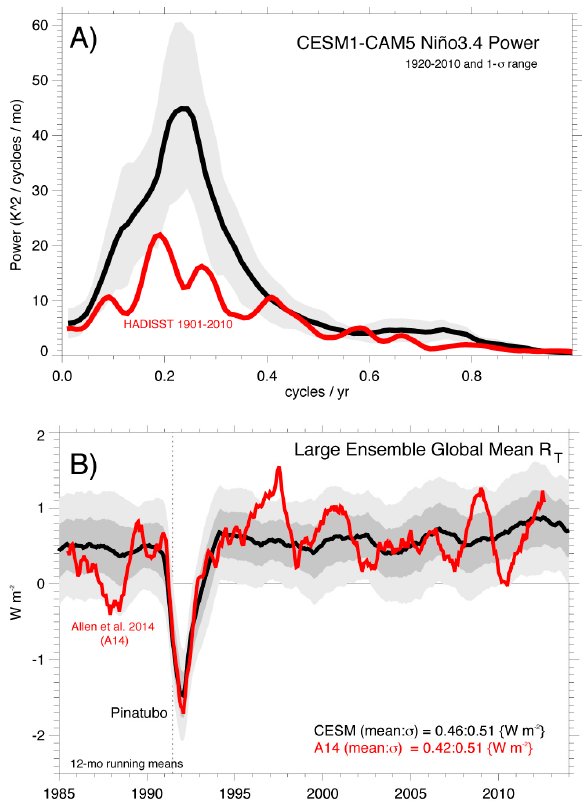
Figure 2. Evaluation of: ( A ) the power spectrum of Niño3.4 sea surface temperature in the LE (black) and an estimate from HADISST (red); and ( B ) the time series of net top ‐ of ‐ atmosphere radiative flux (R T ) in CESM (black) versus the observation ‐ based estimate from 1985 to 2014 (A14, red, [40]). Shading indicates the σ (and 2 × σ in bottom panel light shading) range across ensemble members.